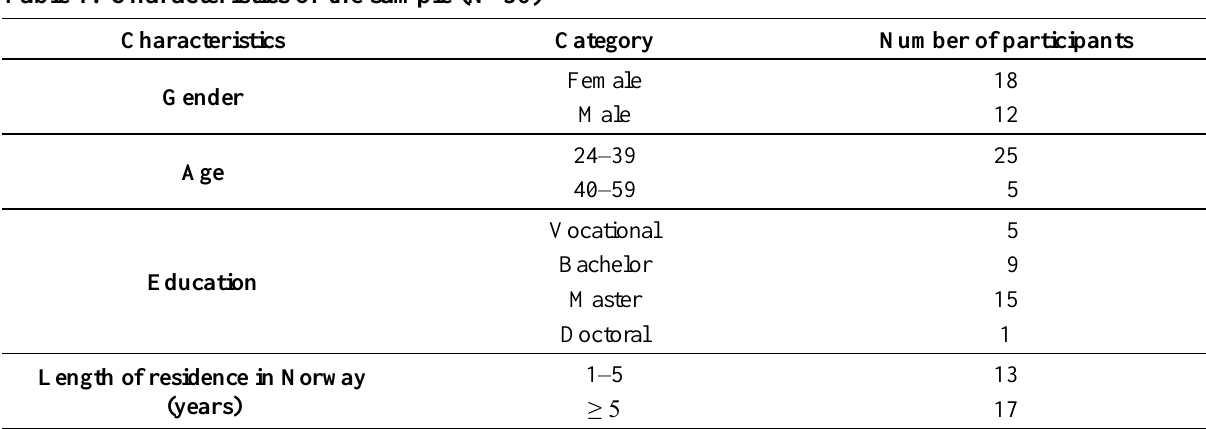
Table 1. Characteristics of the sample